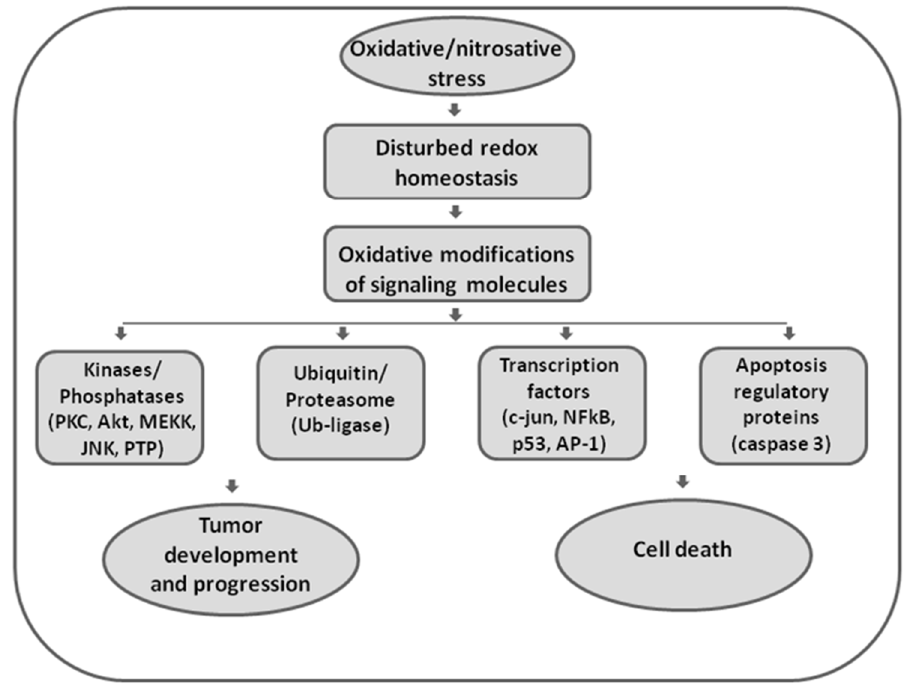
Figure 1. The role of oxidative and nitrosative stress in redox signaling. Disturbed redox homeostasis represents a hallmark of malignant phenotypes, a ff ecting redox signaling in cancer cells. Reactive oxygen and nitrogen species (ROS / RNS) are e ff ective in redox signaling and regulation by a ff ecting the activity of redox-sensitive kinases and phosphatases, enzymes involved in ubiquitin and proteasomal degradation, transcription factors, and executor apoptotic molecules. Being involved in both regulation of proliferation and apoptosis, ROS / RNS seem to have double-faced roles in cancer.